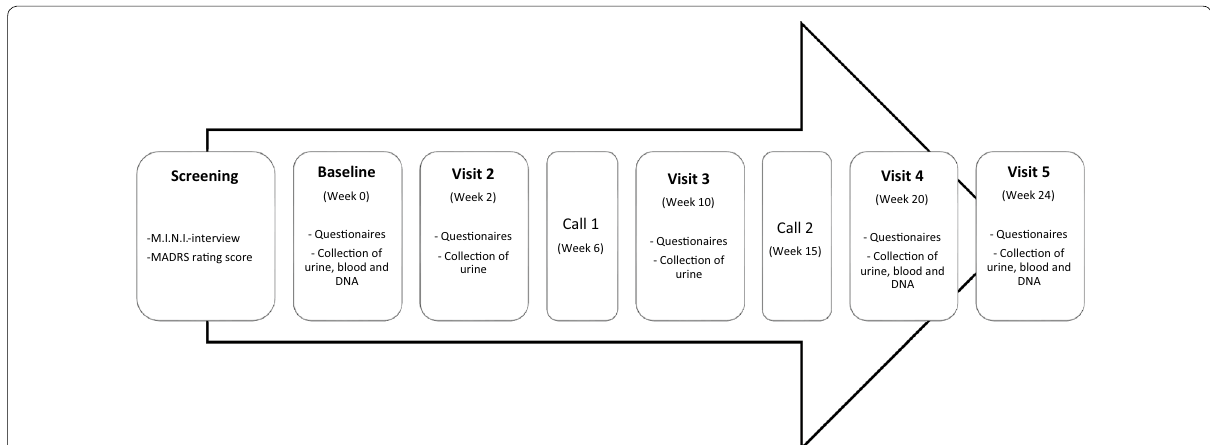
Fig. 1 Timeline with outcomes measures. M.I.N.I-interview Mini International Neuropsychiatric Interview, MADRS Montgomery–Asberg Depression Rating